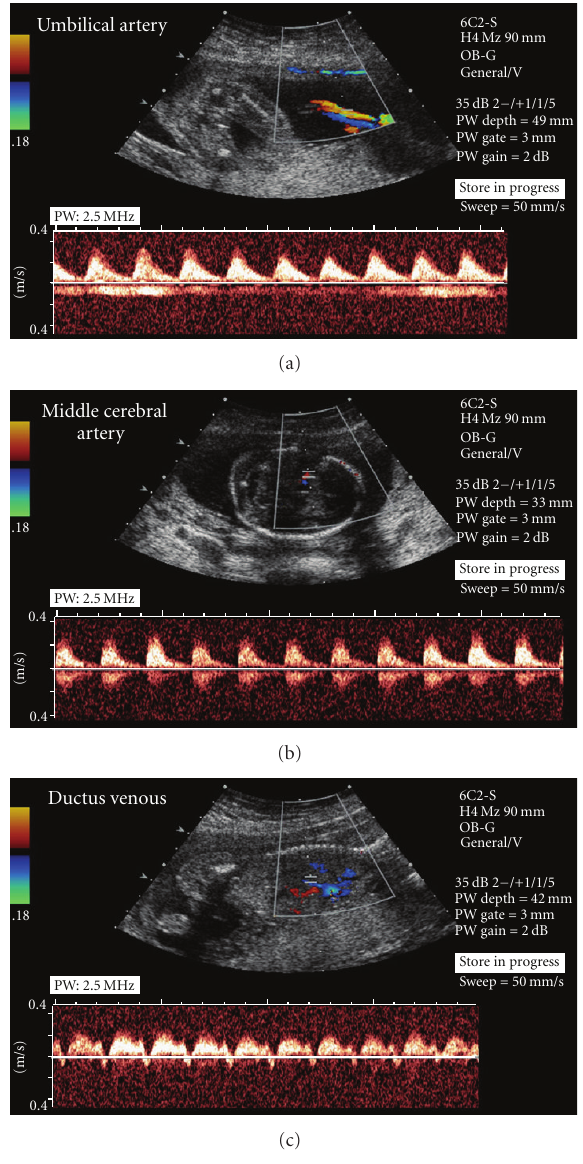
Figure 1: Doppler velocimetry of fetal vessels. (a) depicts a normal umbilical artery flow waveform. (b) depicts a normal waveform of the middle cerebral artery, and (c) depicts an abnormal ductus venosus waveform, showing a reversed “a”